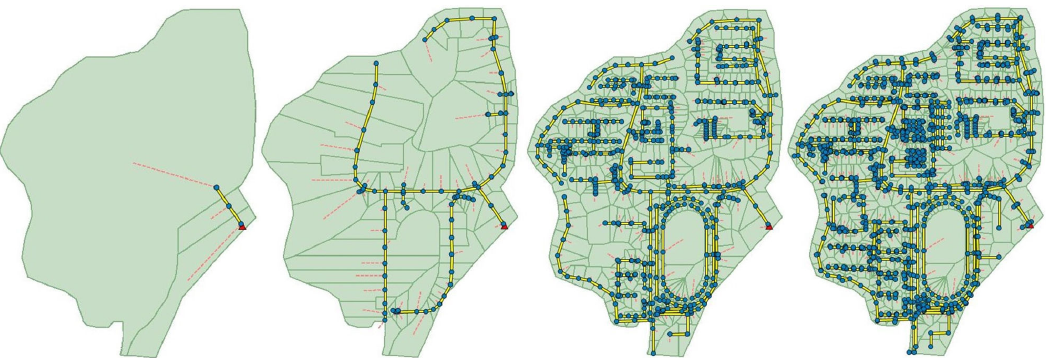
Figure 8. Classification results for four levels of the sewer network and the corresponding discretization results for the northern district.